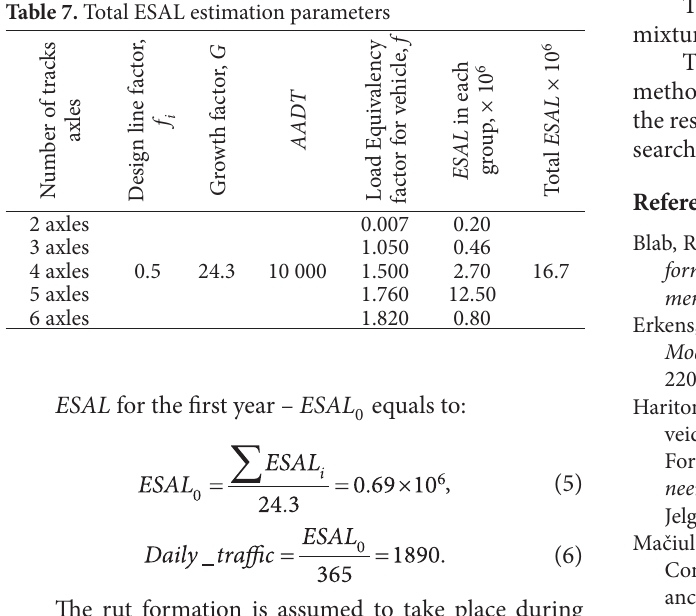
Fig. 3 . Theoretical development of the rut depth on the A4